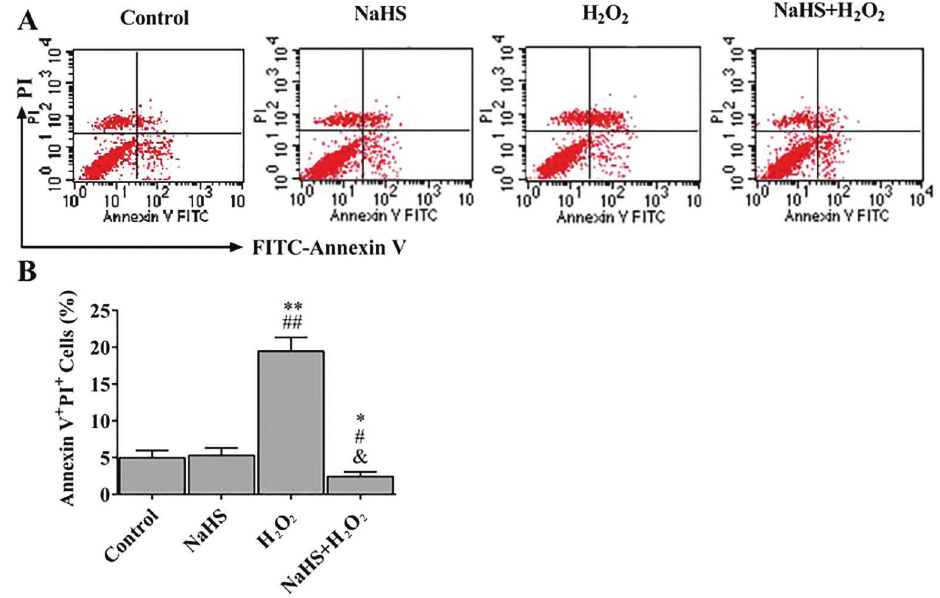
Figure 1. Hydrogen sul fi de (H 2 S) reduced H 2 O 2 -induced H9c2 apoptosis. A , Cell death analysis of treated cells was performed by fl ow cytometry with annexin V/PI double staining. Representative quantitative analysis is shown in B . Data are reported as means ± SE (n=6). *P o 0.05, **P o 0.01 vs control; # P o 0.05, ## P o 0.01 vs NaHS; & p o 0.01 vs H 2 O 2 (ANOVA followed by Student-Newman-Keuls post hoc test).